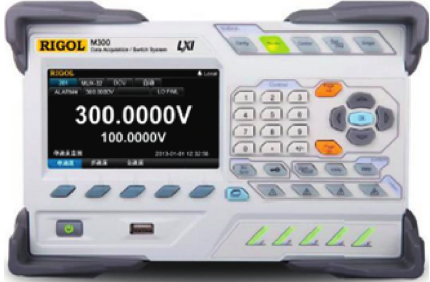
Figure 5: M300 series data acquisition/switching